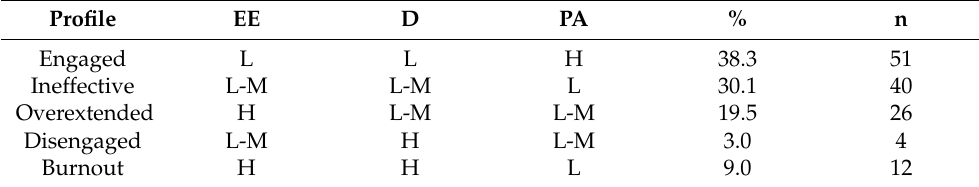
Table 2. Classification of the participants according to the profile model of Leiter & Maslach (2016) [17].